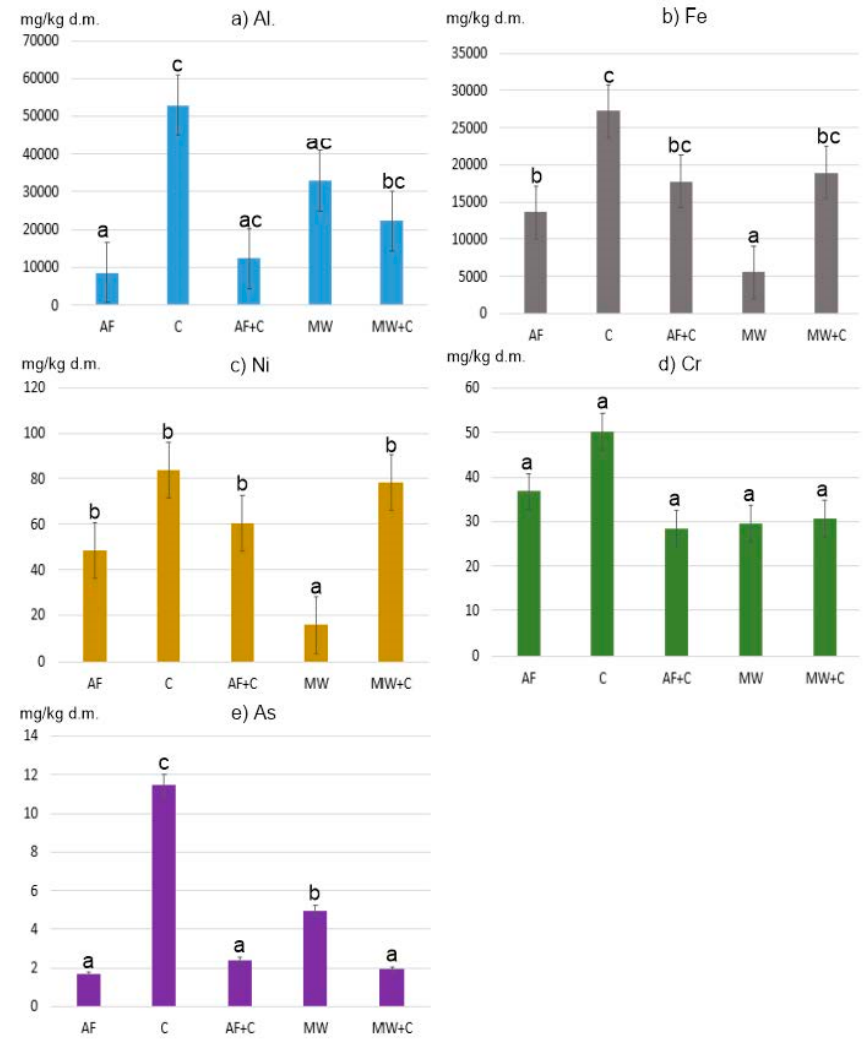
Figure 1. Average content of PTEs in ashes: ( a ) Al, ( b ) Fe, ( c ) Ni, ( d ) Cr and ( e ) As. Means marked with the same letter do not differ at p = 0.05.